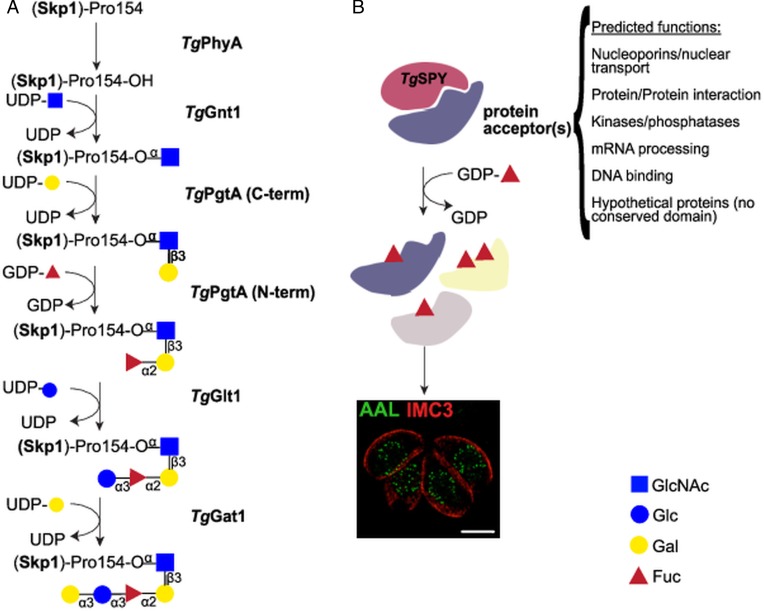
Nucleocytosolic glycosylation pathways in T. gondii. (A) Skp1 glycosylation pathway. Proline 154 of the Skp1 protein is first hydroxylated by TgPhyA and then modified by a pentasaccharide of the composition Galα1,3Glcα1,3Fucα1,2Galβ1,3GlcNAcα1– which is assembled by four glycosyltransferases. Transfer of αGlcNAc to the hydroxylated proline by TgGnt1 is followed by the sequential transfer of β1,3-linked Gal and α1,2Fuc by the bifunctional enzyme TgPgtA. TgGlt1 and TgGat1 transfer the remaining two sugars, Glc and Gal, both in α1,3 linkage. (B) Nucleocytosolic O-fucosylation. TgSPY, a paralogue of animal O-GlcNAc transferases, modifies more than 60 proteins with one or more O-linked fucose residues. Structured illumination microscopy of tachyzoites suggests that the O-fucosylated proteins form assemblies that localize at the nuclear periphery. AAL: Aleuria aurantia lectin (binds to fucose); IMC3: marker for T. gondii inner membrane complex.